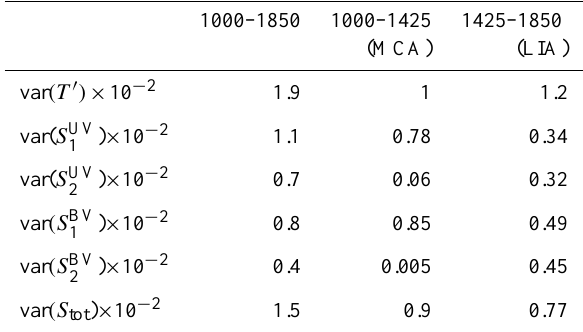
Table 1. Variances of the Northern Hemisphere temperature ( T ) in SGI and the signatures of solar ( S 1 ) and CO 2 ( S 2 ) forcing estimated on the whole period, the first part (1000–1425 AD) and the second part of the millennium (1425–1850 AD). The indices UV and BV denote the methods to estimate the coefficients, i.e. univariate and bivariate regressions, respectively.